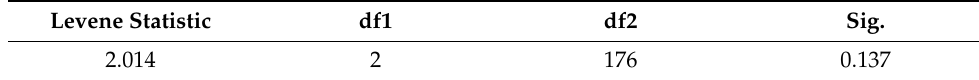
Table 2. Test of homogeneity of variances.